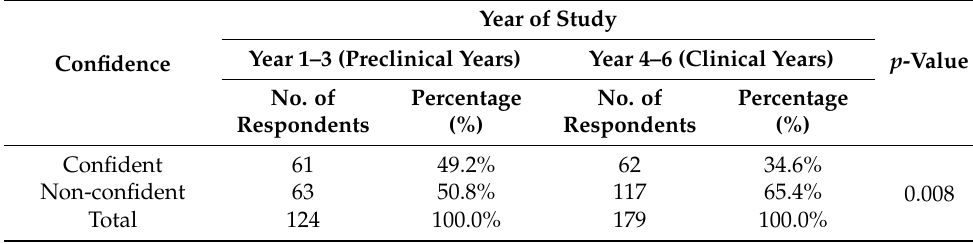
Table A1. Relationship between Year of Study and confidence towards providing palliative care among medical